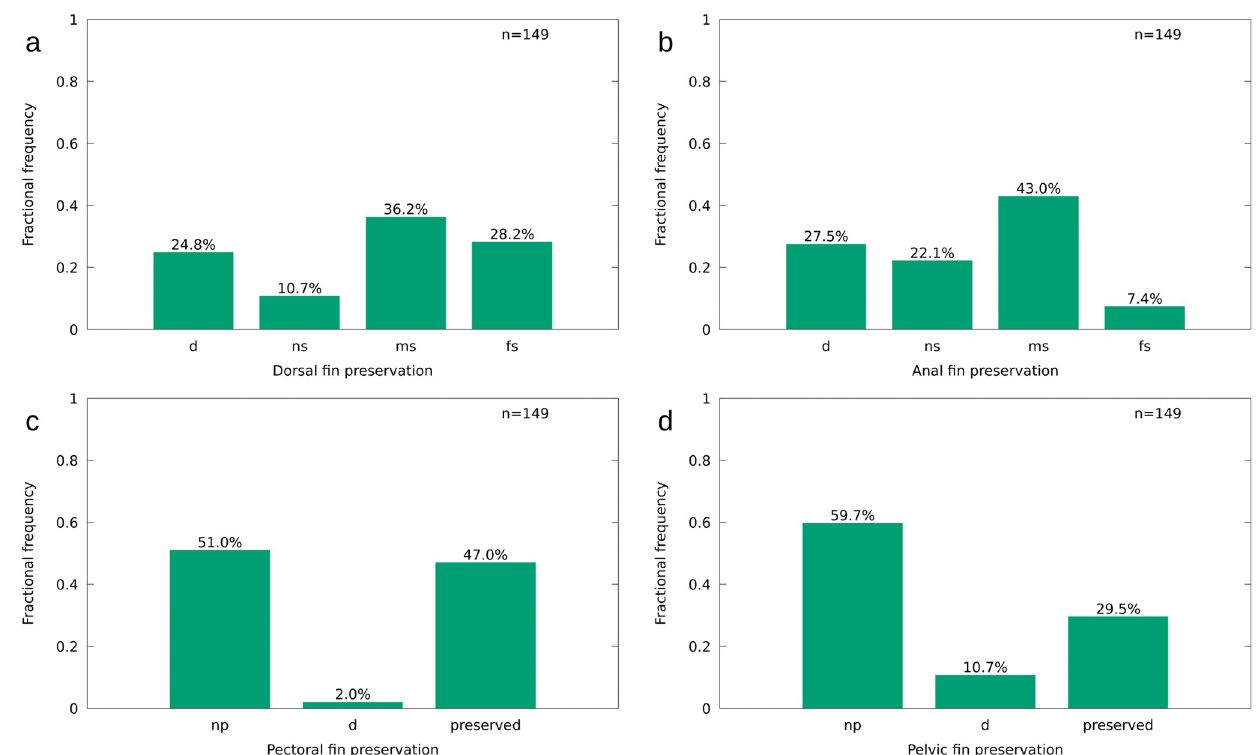
Fig 9. Preservation of the dorsal (A), anal (B), pectoral (C) and pelvic fins (D) of T . formosa , in percent of the total number of individuals. Disarticulated (d), not spread (ns), mostly spread (ms), fully spread (fs), not preserved (np) and preserved.